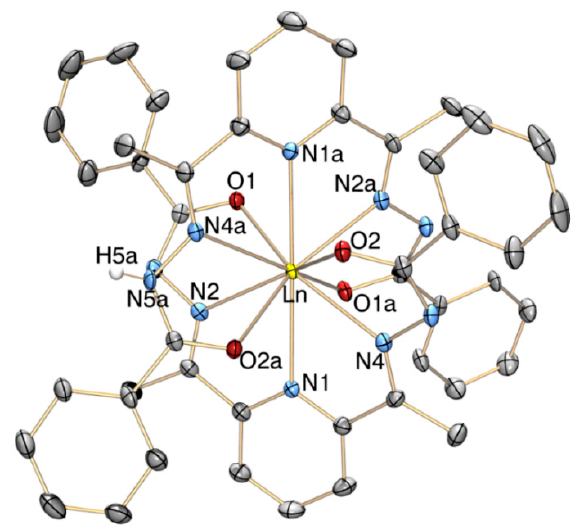
Figure 2. ORTEP representation of the molecular structure of 4-Er complex with 50% thermal ellipsoid probability as an illustration of common structural features of 1 – 4 complexes. Hydrogen atoms are omitted for clarity, except one localized at the N5A atom.